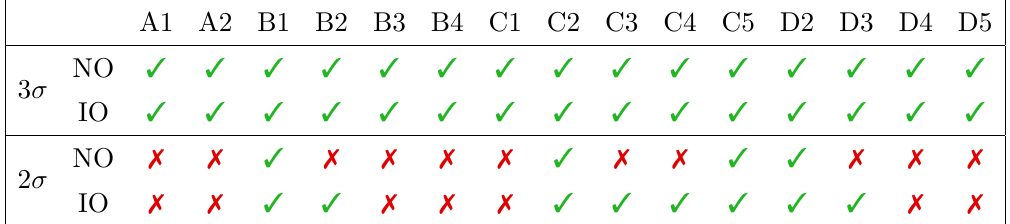
Table 7 . Compatibility of the cases under consideration with the 3 (cid:27) and 2 (cid:27) experimentally allowed ranges of the three neutrino mixing angles for both types of the neutrino mass